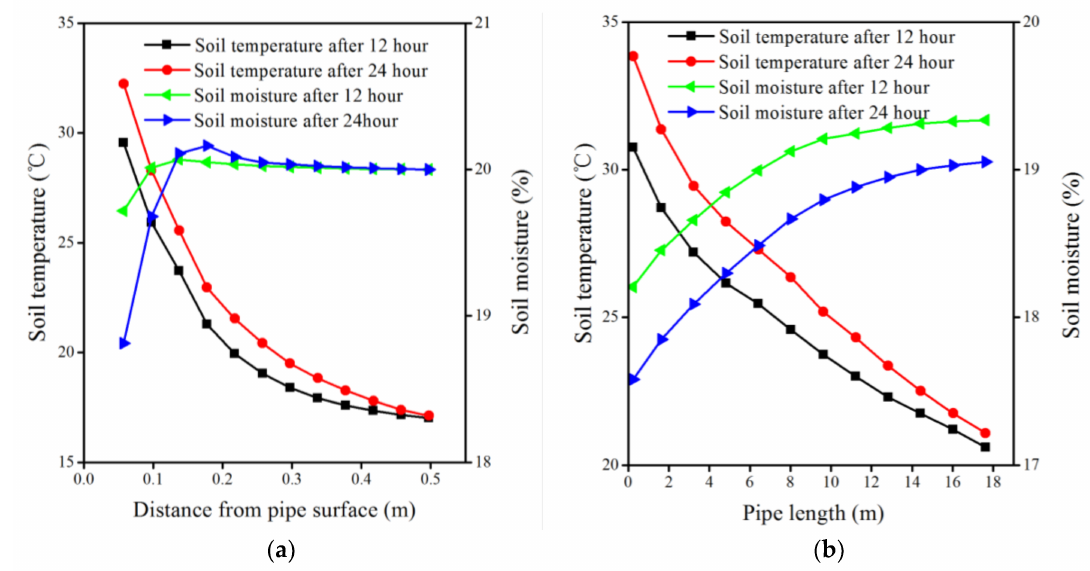
Figure 9. Soil temperature and moisture profiles along the ( a ) radial direction; and ( b ) the axial